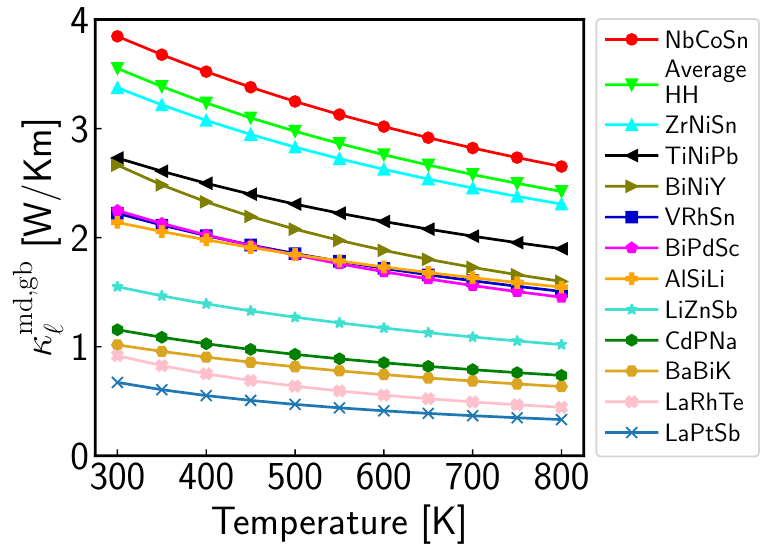
Figure 3. κ md,gb as a function of temperature, with substitution on the optimal site and a domain (cid:96) size of 100 nm. The temperature is indicated on the horizontal axis, and κ md,gb